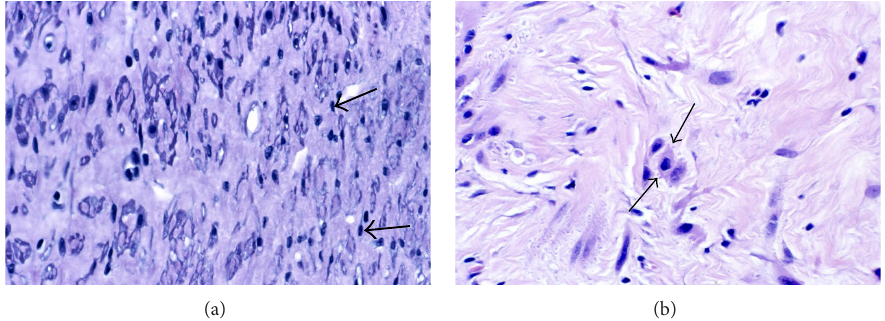
Figure 8: (a) Wispy atrophy of tumor myocytes. As collagen production and deposition continues, the tumor myocytes become further encased in matrix, progressively more atrophic, and often reduced to slender, wispy structures. Note that not only the cytoplasm but also the nuclei of some cells appear to be reduced in size (arrows). (b) Lateral buds versus pinnate atrophy. Sometimes the atrophic cells exhibit lateral projections (arrows), which are similar to the previously described lateral buds associated with phenotypic transformation (Figure 7), but are occurring late in the atrophic process. Whether these lateral projections are the residua of lateral buds, or whether they might represent a form of decapitation budding associated with the atrophic process (pinnate atrophy) is uncertain. Original magnification of (a) and (b): 132x.